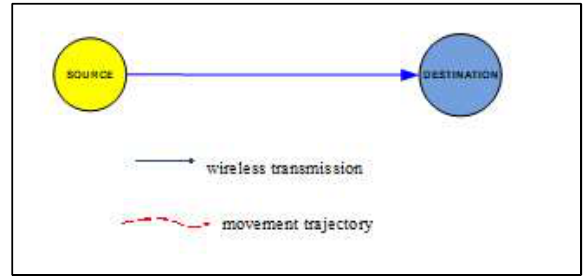
Figure 3. Direct communication